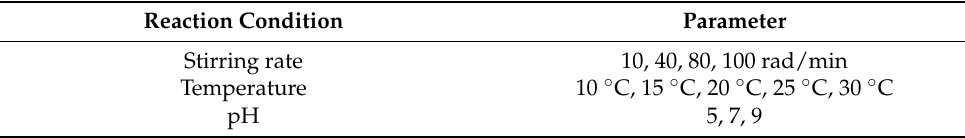
Table A3. The reaction condition parameters of experimental system.